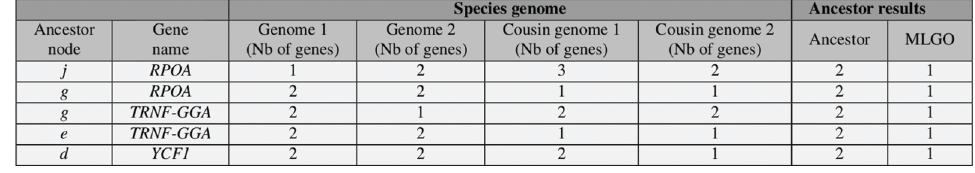
Figure 10: The variation in comparison results of ancestral genomes nodes on Asterales order with